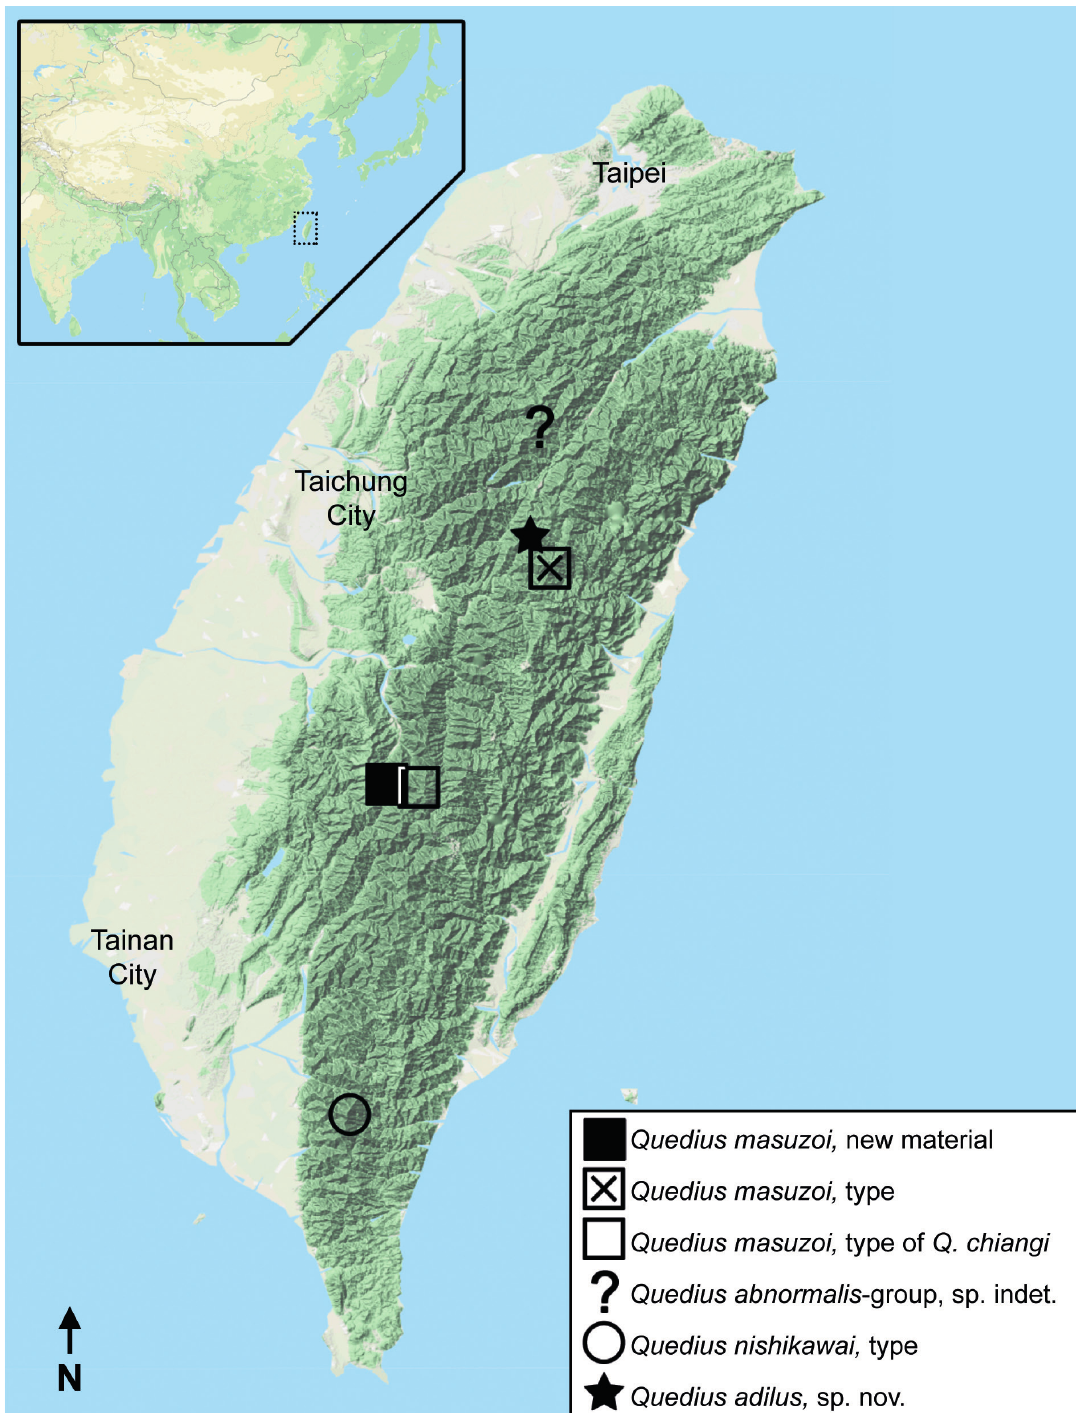
Fig. 2. Distribution of species in the Quedius abnormalis group in Taiwan. Filled square  refers to the new specimens of adults and larvae of Quedius masuzoi Watanabe, 1989 reported in this paper. Square with cross  is the type locality of Quedius masuzoi . Unfilled square  is the type locality of Quedius chiangi Smetana, 1995, junior synonym of Q. masuzoi . Question mark (?) refers to an undescribed female specimen reported in Watanabe (1989). Unfilled circle  is the type locality of Quedius nishikawai Watanabe, 1991. Filled star  is the type locality of Quedius adilus sp.